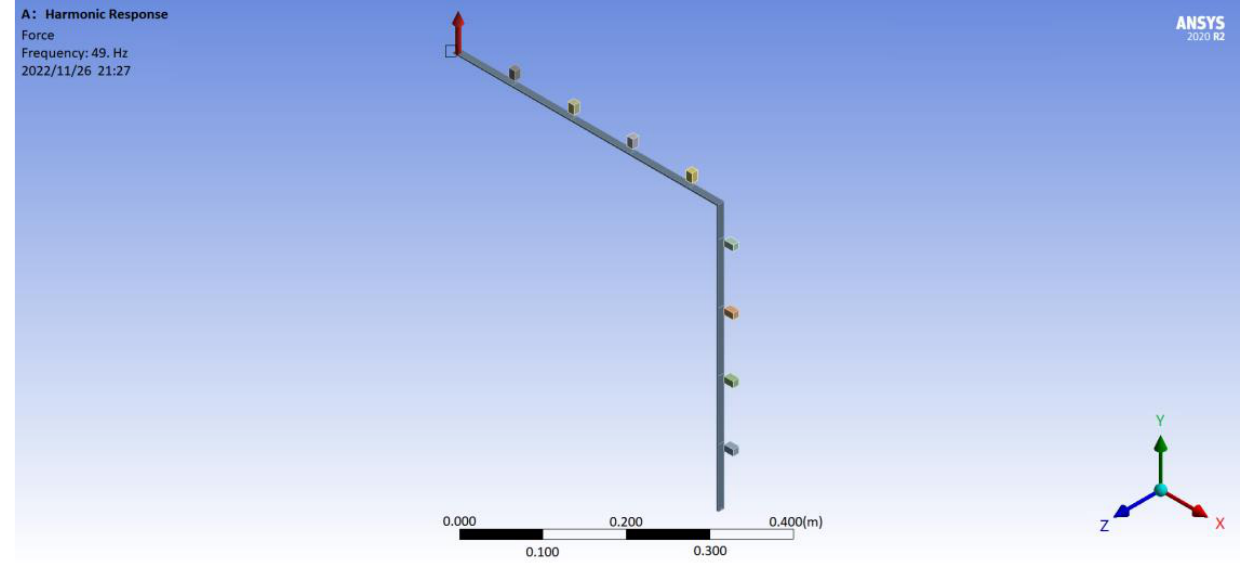
Figure 11. The geometrical model for the simulation. Considering the notable impact of the axial waves on the transverse vibration of L-joint of the LR beam, the longitudinal-force-moment type resonators are applied in the LR beam to further widen the band gaps, where two kinds of band gaps are generated for the different positions of the longitudinal-force-moment type resonators. Firstly, the longitudinal-force-moment type resonators are set at the first two cells of the LR beam (considered as LR beam 2). The other case is that the longitudinal-force-moment type resonators are set at the third and fourth cells of the LR beam (considered as LR beam 3). Similarly, we name the LR beam suspended only with transverse-force type resonators as LR beam 1 here. For LR beam 2, Equations (85) and (86) are as follows; correspondingly, substitute Equations (54) and (55) to form the coefficient matrix. For LR beam 3, Equations (56) and (57) are replaced with Equations (87) and (88) as